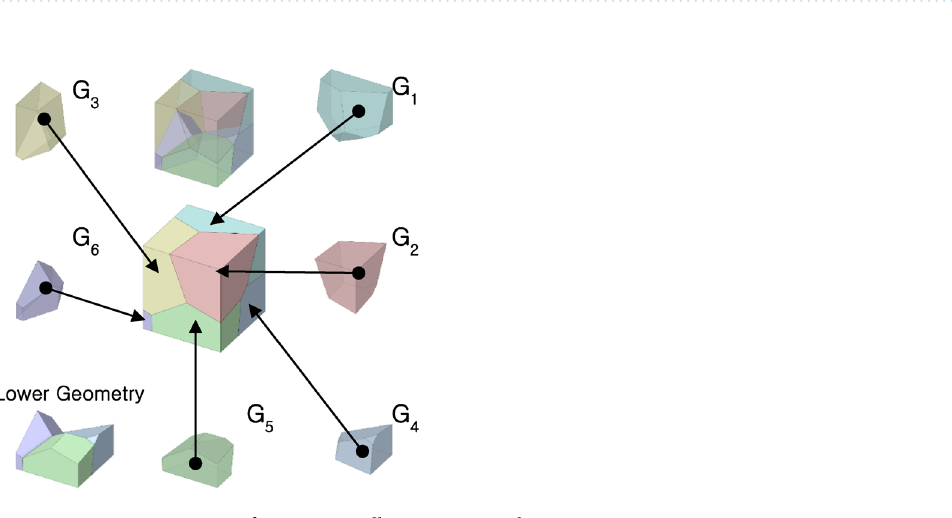
Figure 5. MGS comprises of 6 Voronoi cells as a test